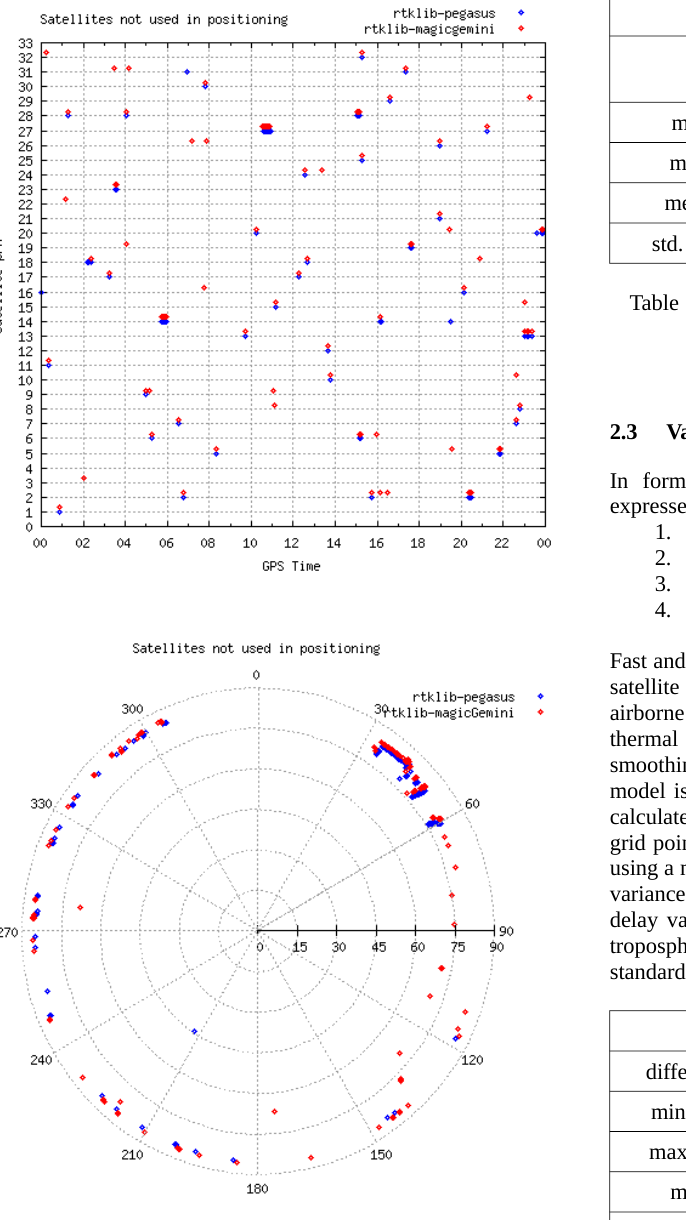
Figure 3. Satellites used in positioning by RTKLIB, but not by Pegasus and magicGemini